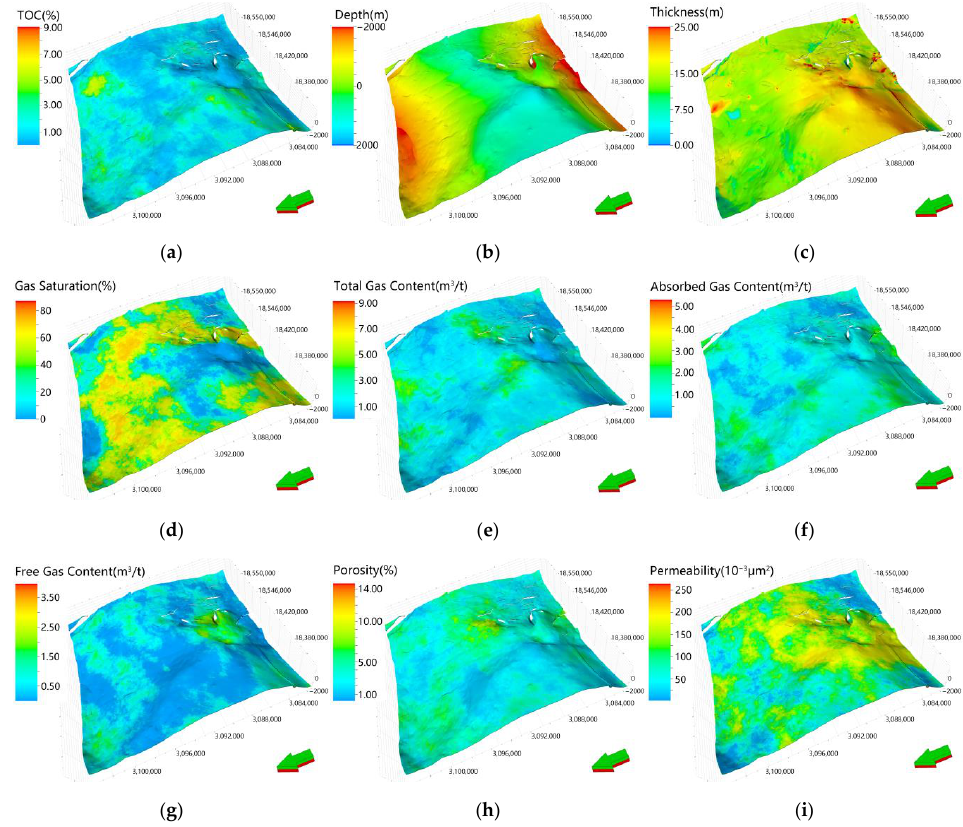
Figure 6. Three-dimensional evaluation index model of geological sweet spots in the study area: ( a ) organic matter abundance (TOC); ( b ) reservoir formation thickness; ( c ) reservoir burial depth; ( d ) gas saturation; ( e ) total gas content; ( f ) adsorbed gas content; ( g ) free gas content; ( h ) porosity; ( i ) matrix permeability (models visualized by Schlumberger Petrel software). Table 4. Sweet spots division standard based on sweetness in study area.